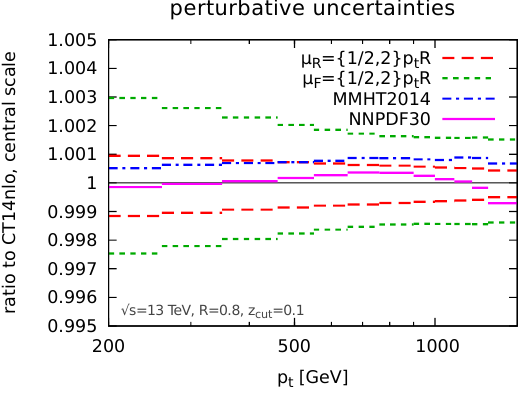
Figure 17 . Theoretical uncertainties on the ratio ( d(cid:27)=dp t; mMDT ) = ( d(cid:27)=dp t; jet ). Uncertainties asso- ciated with the choice of the renormalisation and factorisation scales as well as with the choice of PDF are shown relative to the ratio obtained for the central scale choice and our default CT14nlo PDF